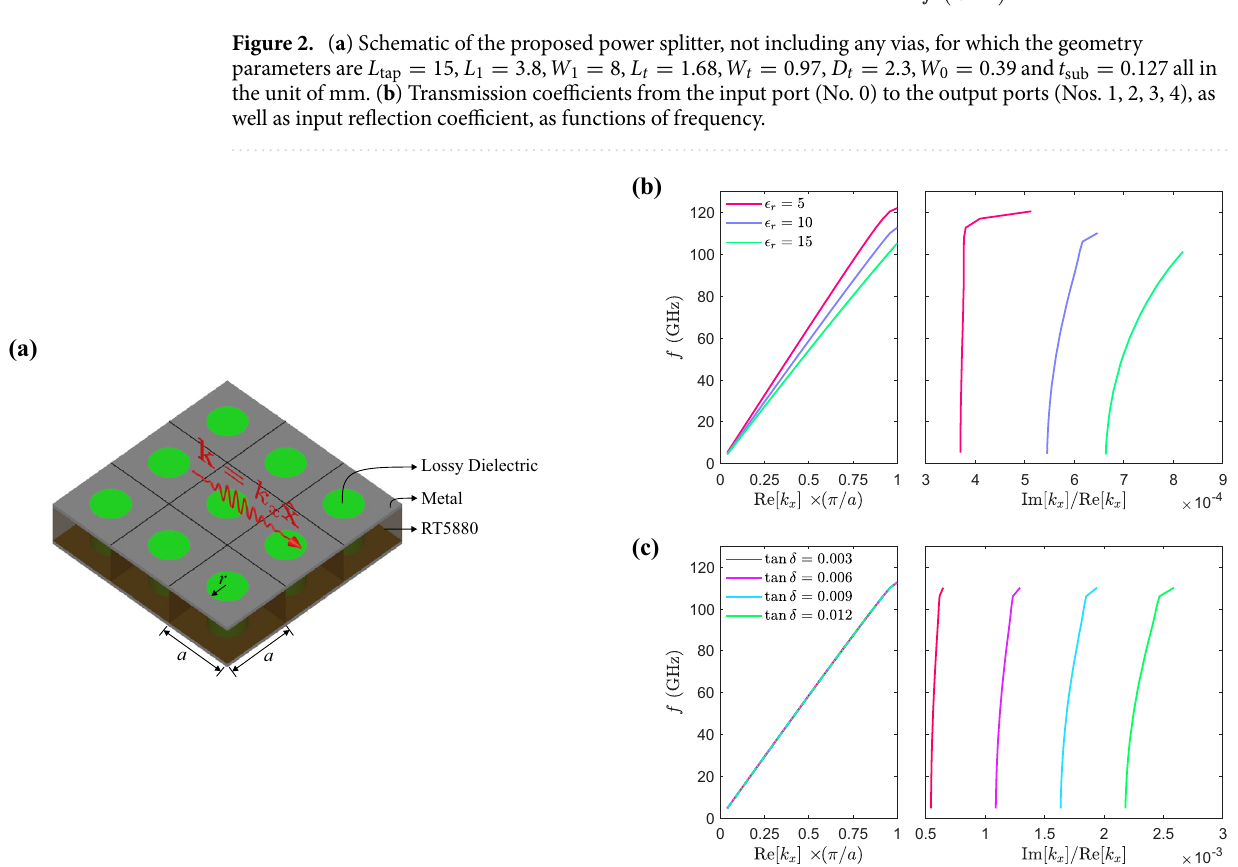
Figure 3. ( a ) periodic array of dielectric vias embedded in the grounded substrate, of which the upper side is covered by metal in areas without holes. The geometric parameters of the structure are a r 0.2 mm. ( b ) dispersion curves for the mode propagating along the red arrow, i.e., the x -direction, in the = periodic structure ( a ) for some discrete value of ε r . ( c ) dispersion curves for variation of loss tangents for ε r = 10